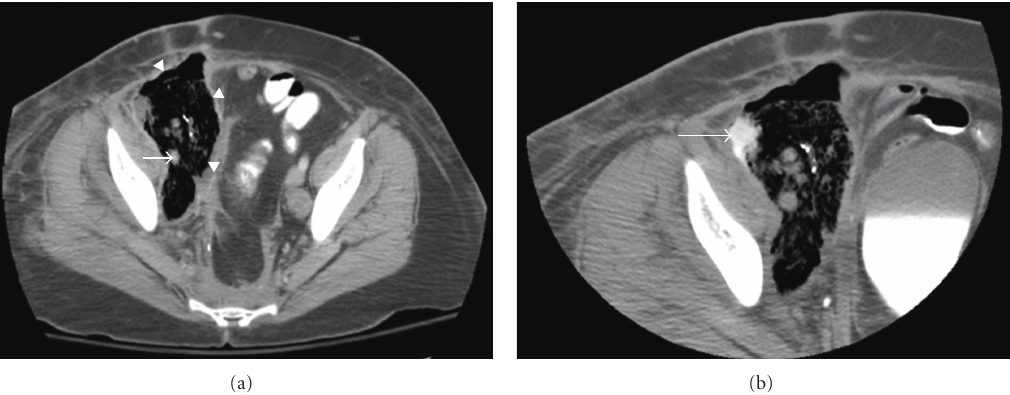
Figure 1: Contrast-enhanced pelvic CT (a) reveals 12 × 7cm air- and fluid-filled abscess (arrowheads) in abdominal right lower quadrant. Encasement of right external iliac artery (arrow) by abscess noted. (b) Presence of bowel contrast (arrow) within collection confirms fistula to colon.